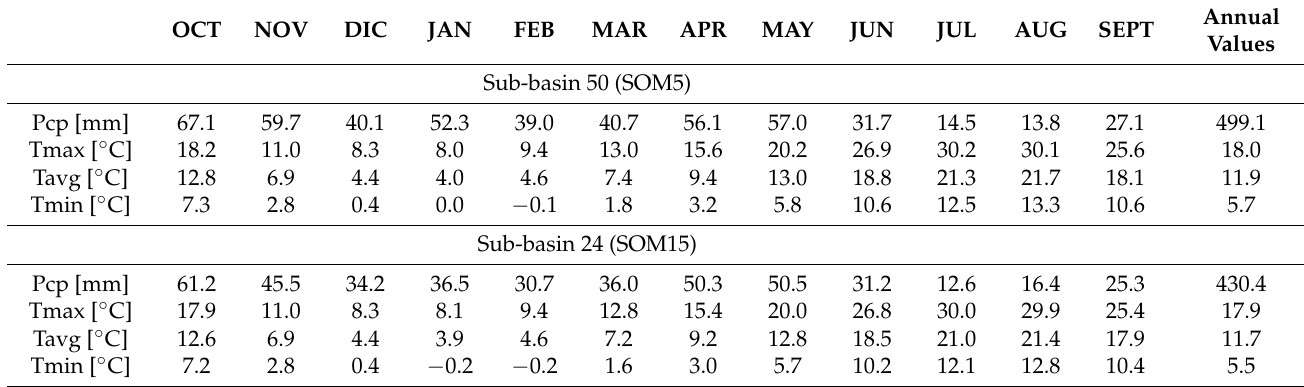
Table 2. Monthly average values of precipitation (Pcp), maximum temperature (Tmax), average temperature (Tavg), minimum temperature (Tmin). Study period from